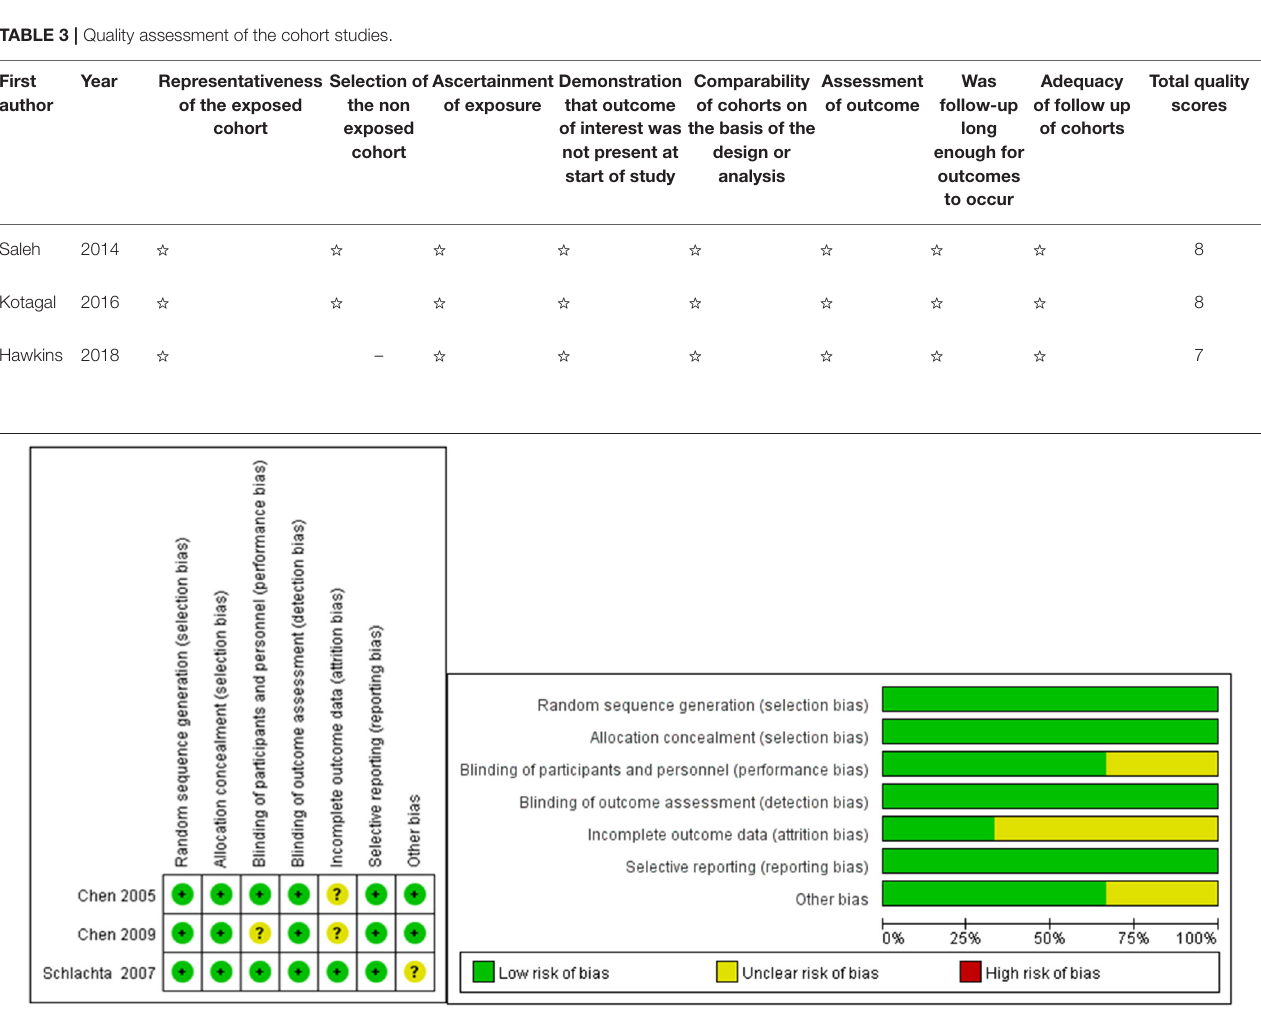
FIGURE 2 | Risk of bias assessment of RCT